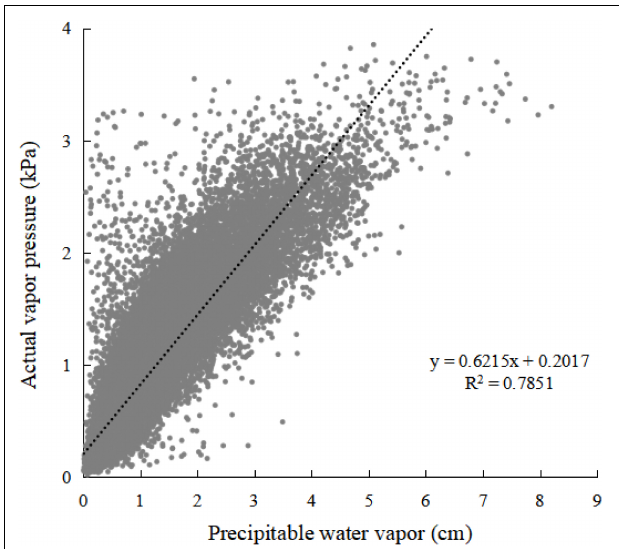
FIGURE 4 | Relationship between the actual vapor pressure and atmospheric precipitable water in Haihe River Basin.